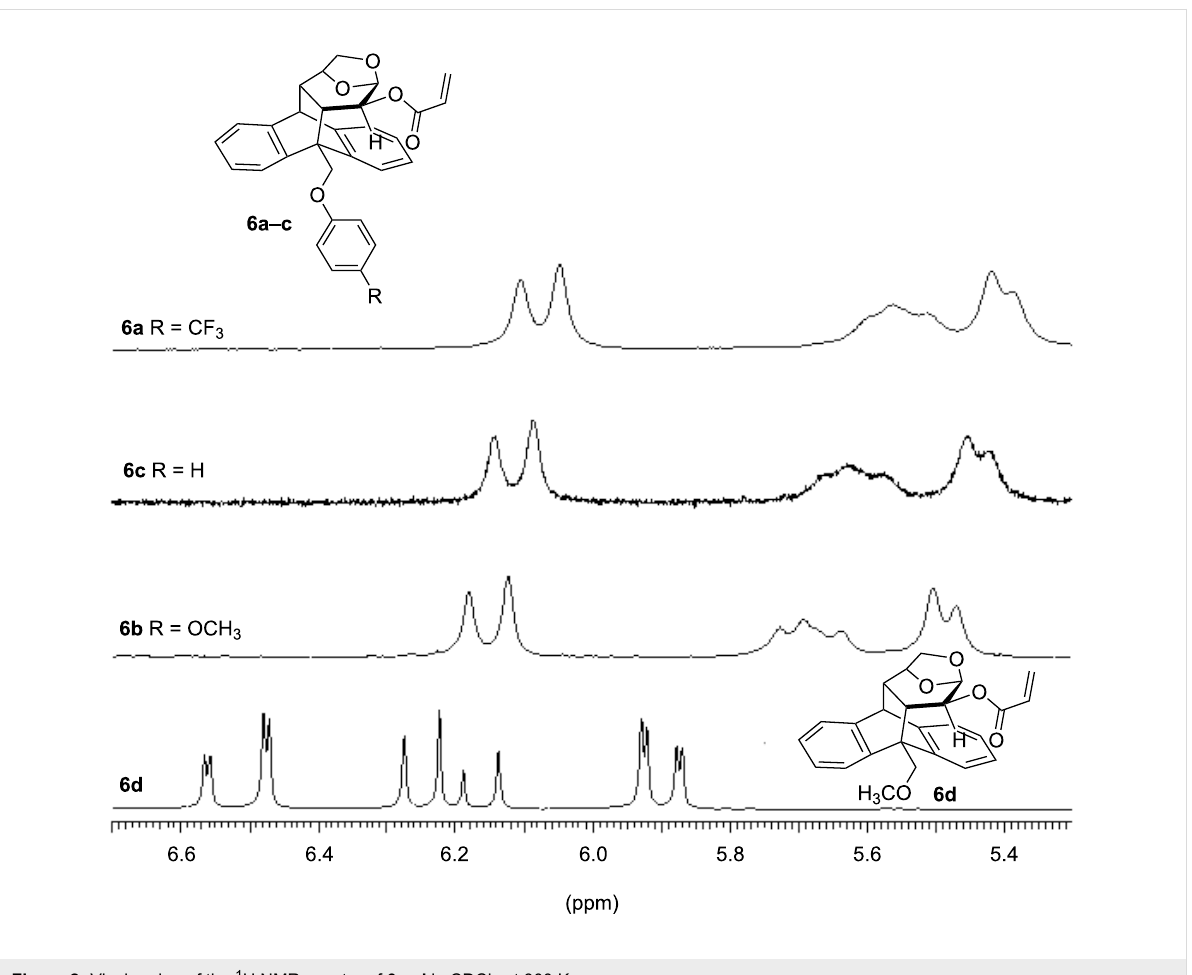
Figure 2: Vinyl region of the 1 H NMR spectra of 6a – d in CDCl 3 at 300 K.